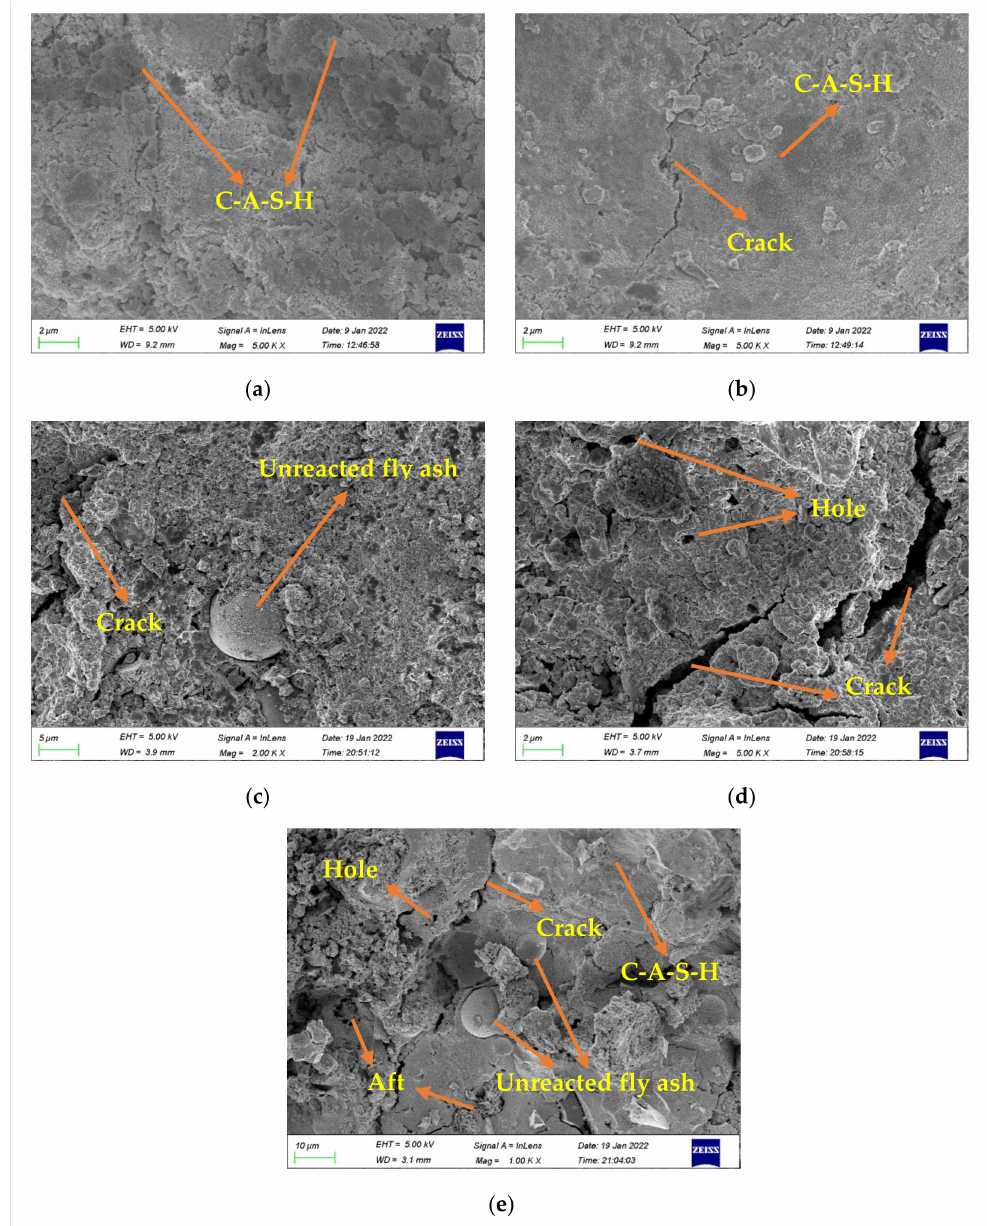
Figure 13. SEM images of fractured surface for specimens: ( a ) M, ( b ) MFA10, ( c ) MFA20, ( d ) MFA30 and ( e )